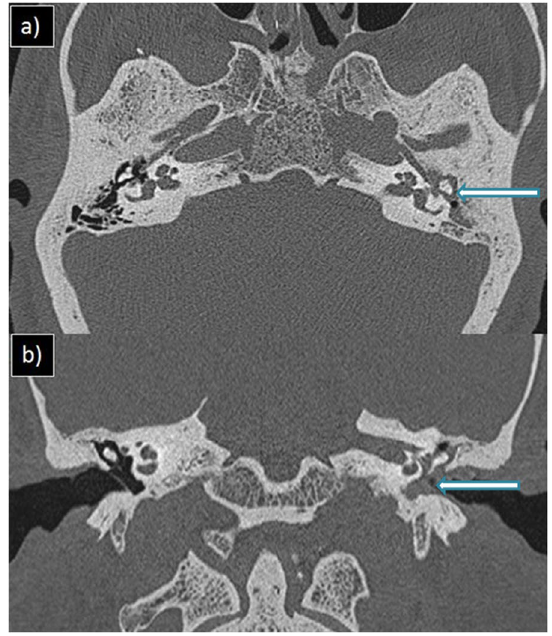
Fig. 9 a axial and b coronal HRCT temporal bone images of 40-year-old female patient of with complaints of otalgia showing soft tissue attenuation in left middle ear and mastoid air cells with no obvious bone/ossicular erosions (arrow)—non-invasive oto-mastoiditis